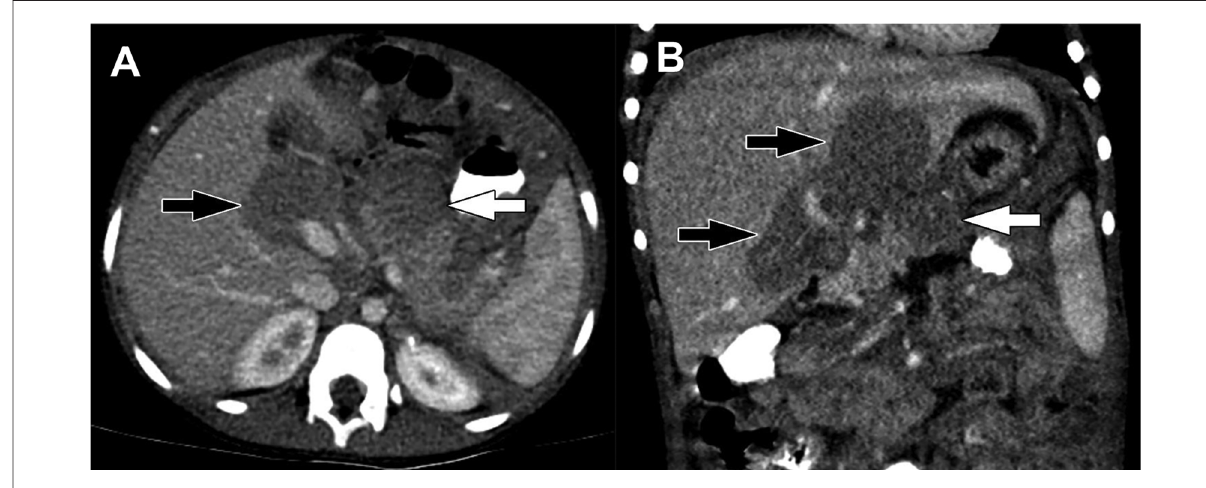
FIGURE 8 Burkitt lymphoma. ( A ) Axial and ( B ) Coronal reformatted images from a CT of the abdomen obtained in the portal venous phase following intravenous contrast material administration show hypoenhancing masses in the pancreas (white arrows) and porta hepatis (black arrows). Multiorgan involvement and in fi ltrative growth are highly suggestive of Burkitt